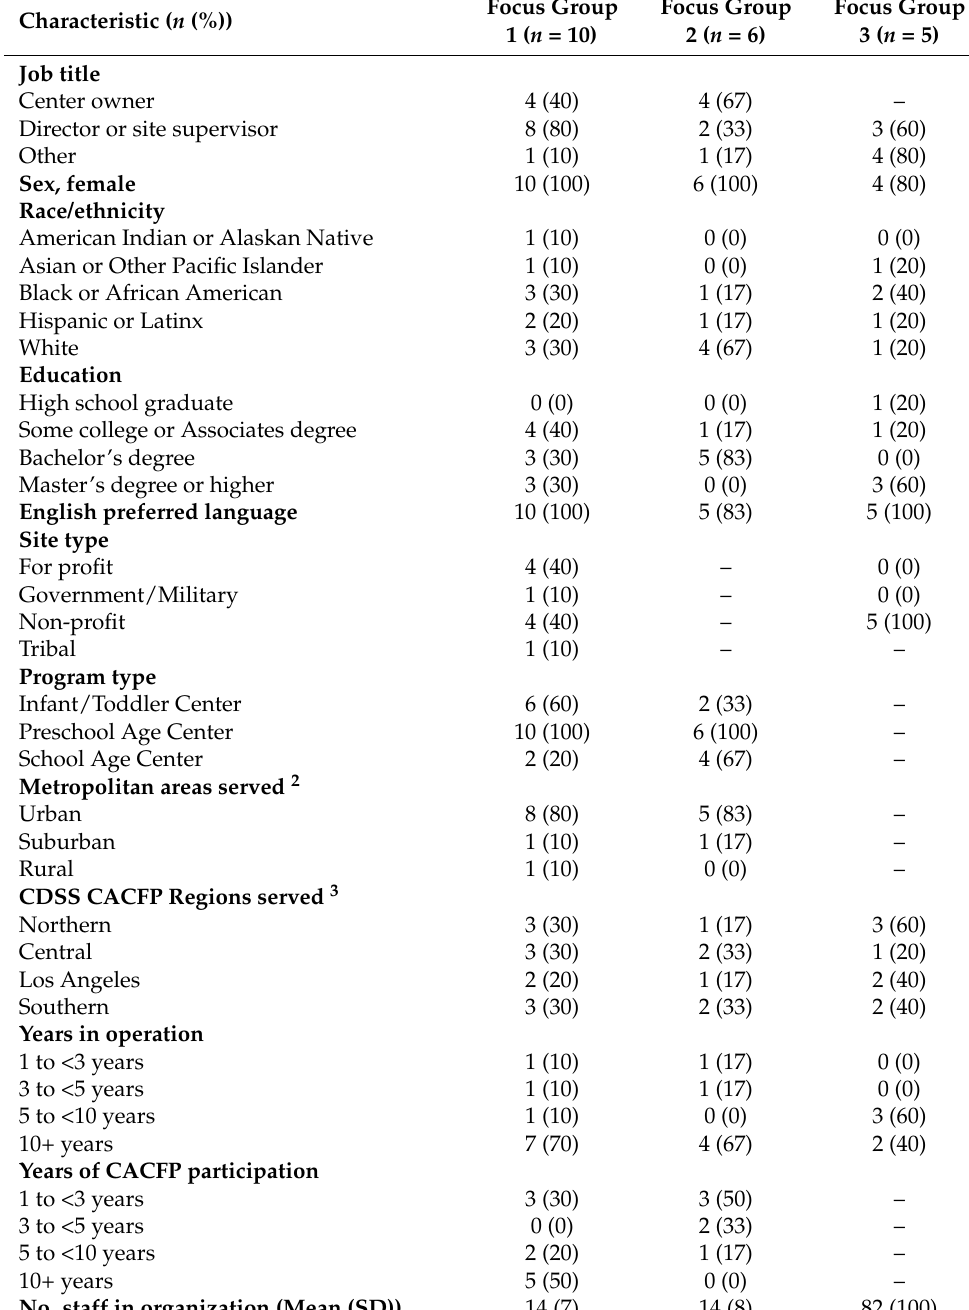
Table 2. California Child and Adult Care Food Program (CACFP) focus group participant and child care site or sponsoring organization characteristics 1